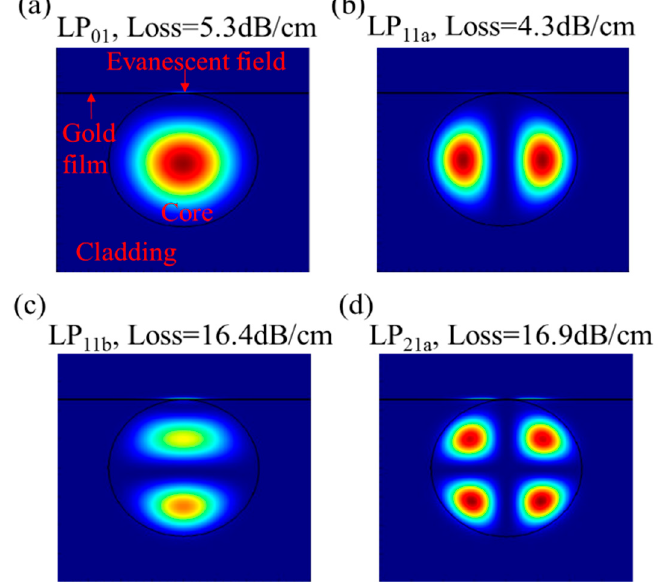
Figure 2. Field distributions in the fiber for modes ( a ) LP 01 , ( b ) LP 11a , ( c ) LP 11b , and ( d ) LP 21a at 650 nm.